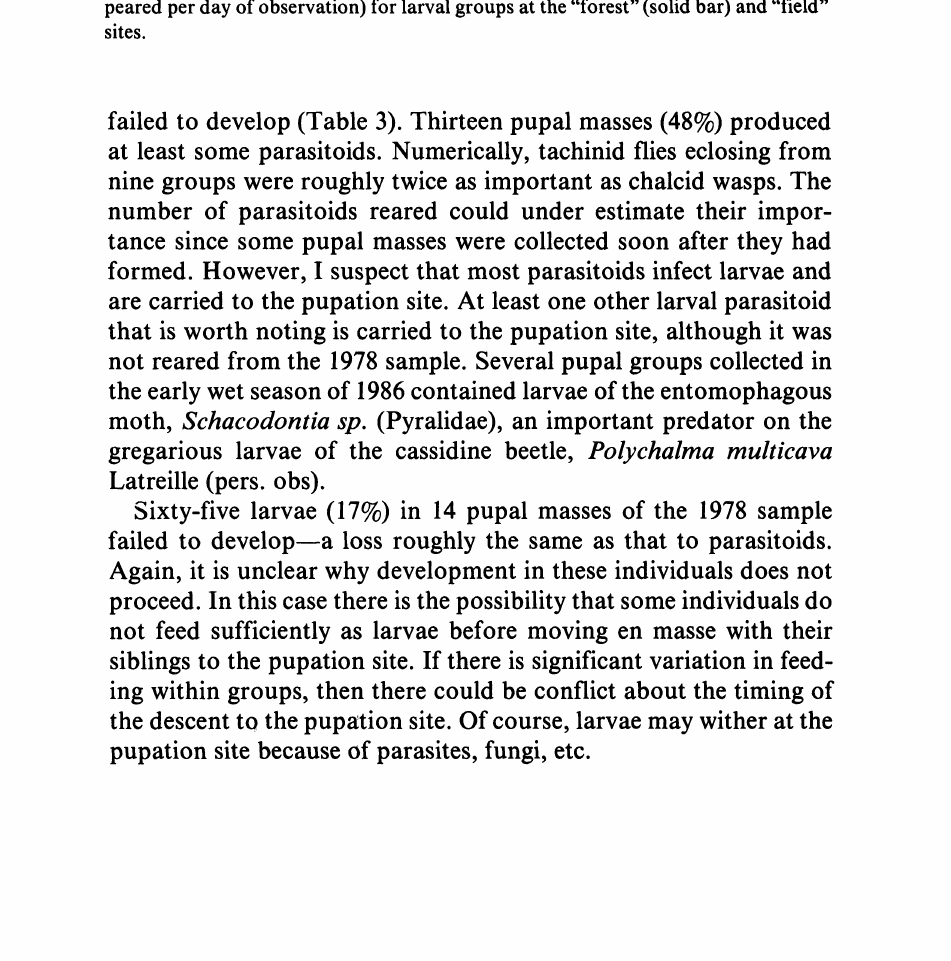
Fig. 3. Comparison of the disappearance rates (number of individuals disap- peared per day of observation) for larval groups at the "forest" (solid bar) and "field"